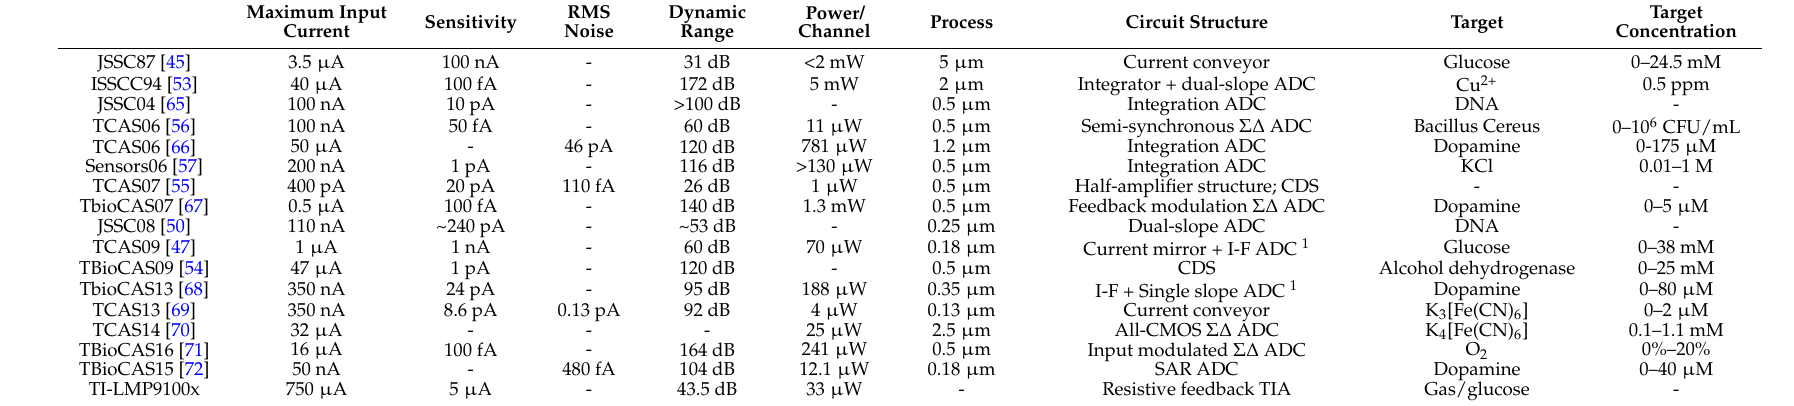
Table 1. Performance summary of amperometric current readout circuitry. CDS, correlated double